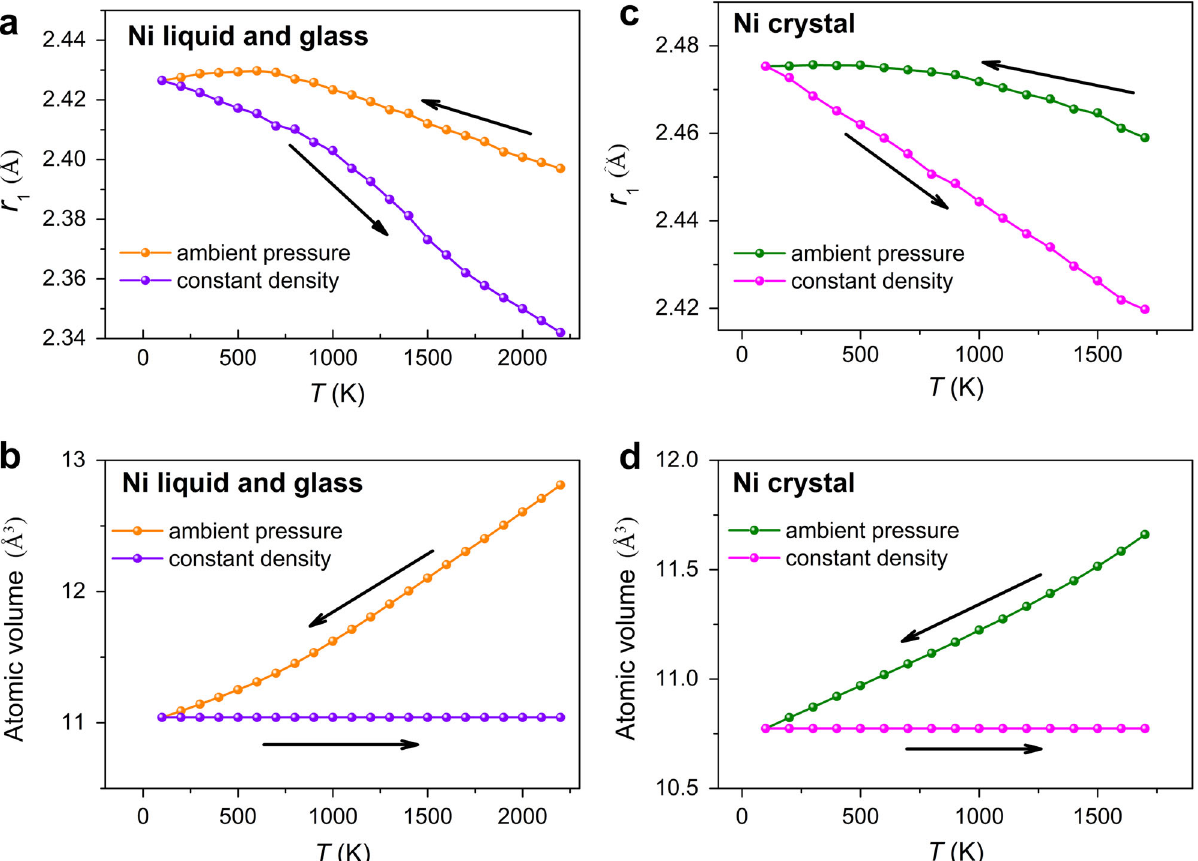
Fig. 6 First peak in g ( r ) for Ni liquid/glass and crystals. a and b are the fi rst peak position( r 1 ) in PDF and atomic volume, respectively, for Ni liquids/glasses at various temperatures under constant density or constant ambient pressure; c and d are r 1 and atomic volume, respectively, for Ni crystals at various temperatures under constant density or ambient pressure. The arrows in a – d indicate the process of simulation: the system was fi rstly quenched from high temperature to 100 K under ambient pressure, and then heated under constant density. Data in a – d are calculated according to the methods in refs. 33 and 35 with EAM potential developed by H. W. Sheng